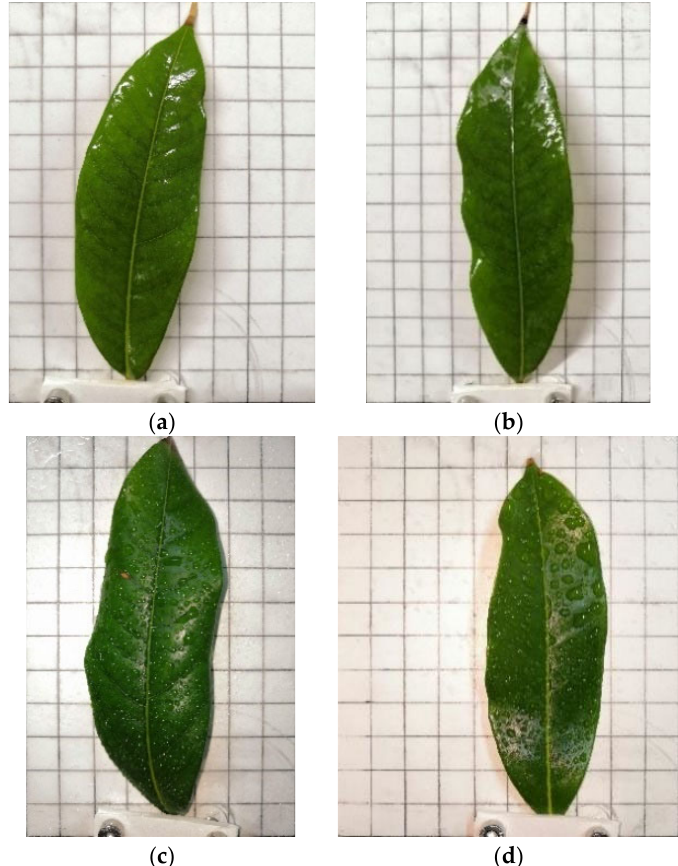
Figure 7. Effect of droplet deposition for different Weber numbers: ( a ) W e = 188.5; ( b ) W e = 144.3; ( c ) W e = 84.3; ( d ) W e = 62.1.